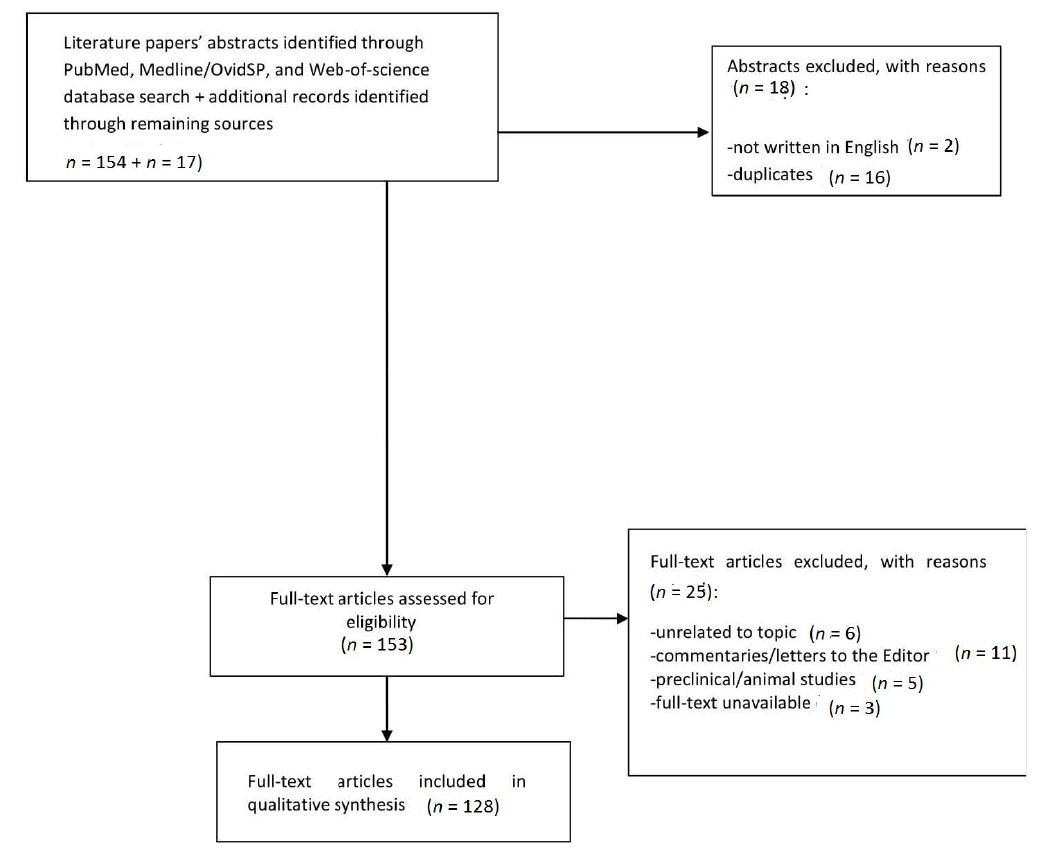
Figure 1. Selection of retrieved studies.